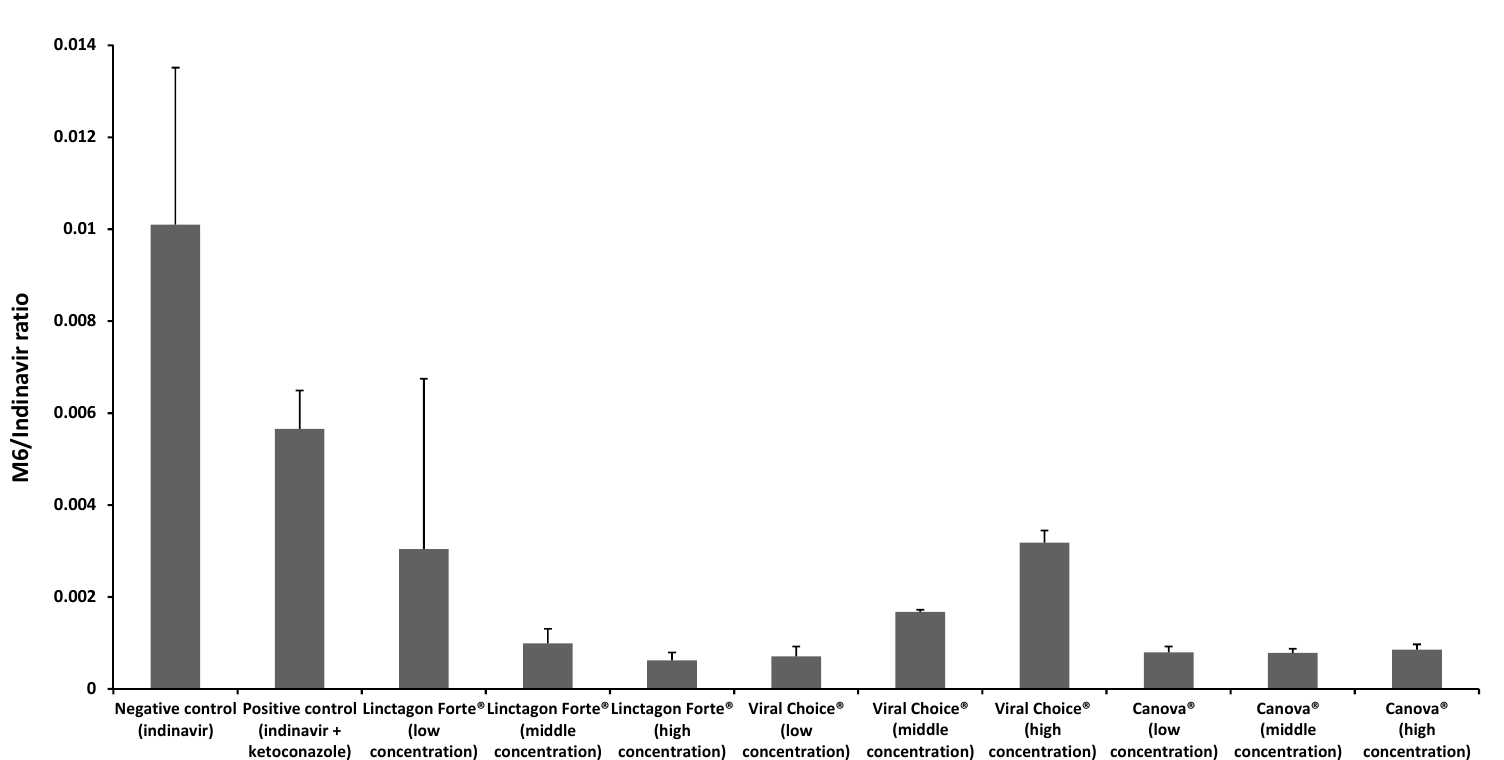
Figure 4. M6/indinavir ratios in the presence of Linctagon Forte ® , Viral Choice ® and Canova ® with the negative control group (indinavir alone) and positive control group (indinavir with ketoconazole). n = 3, error bars indicate standard deviation.